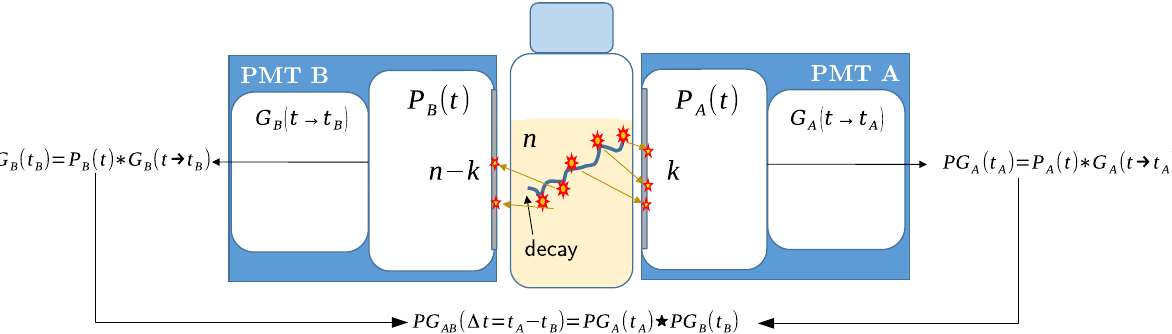
Figure 1. Schematic description of a two PMT LSC system, the considered processes in the time domain and the basic equations that describe them. The symbols ⋆ and operators,